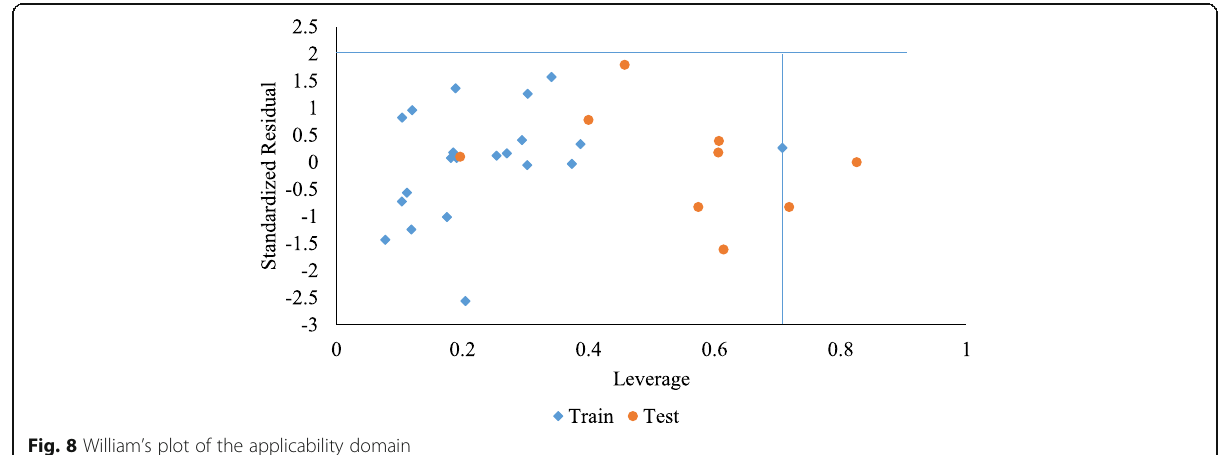
Fig. 8 William ’ s plot of the applicability domain